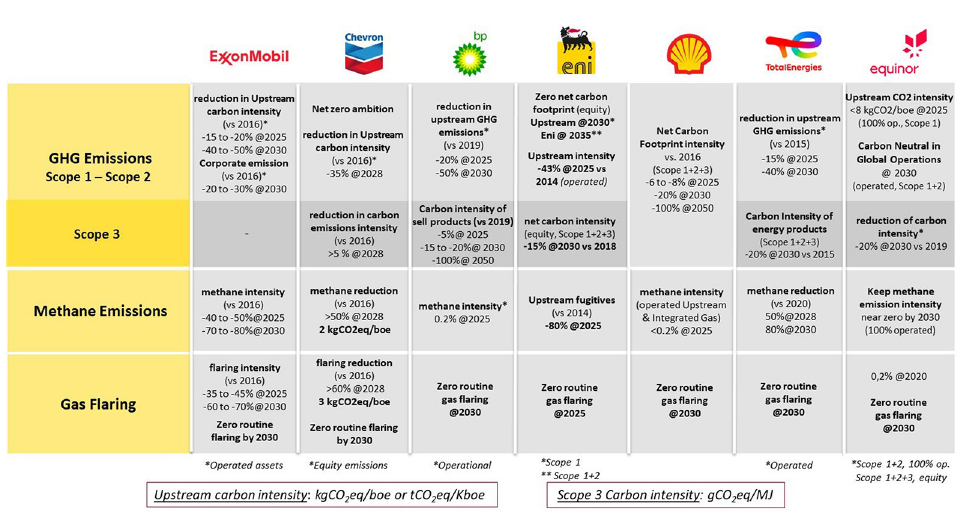
Fig. 22. – The approach of Eni and its peers to setting Greenhouse Gas (GHG) emissions targets (Source: Eni, 2022).